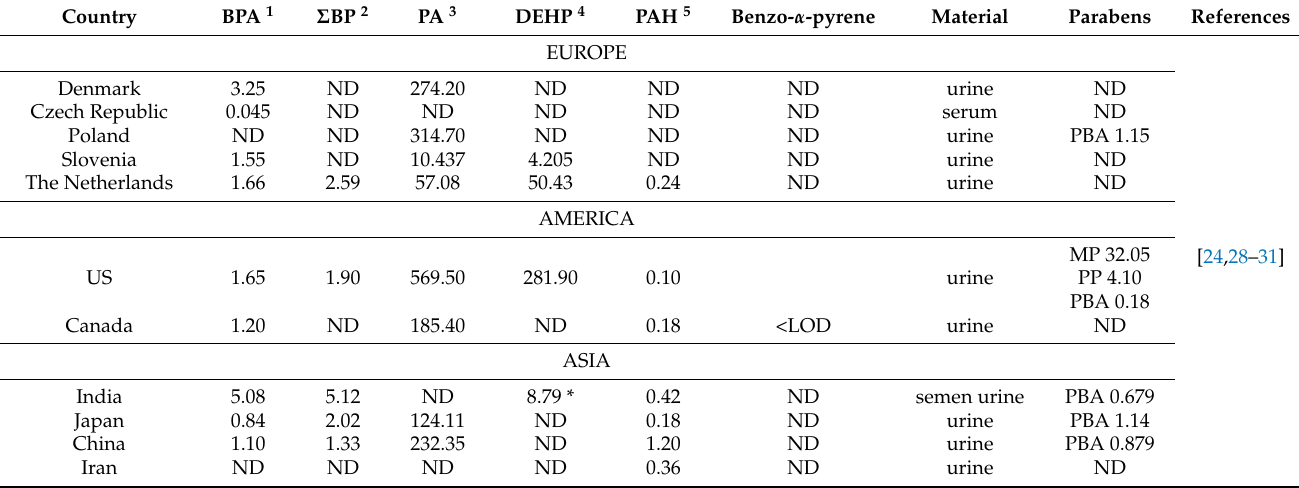
Table 1. Levels of selected EDCs in human samples (ng × mL − 1